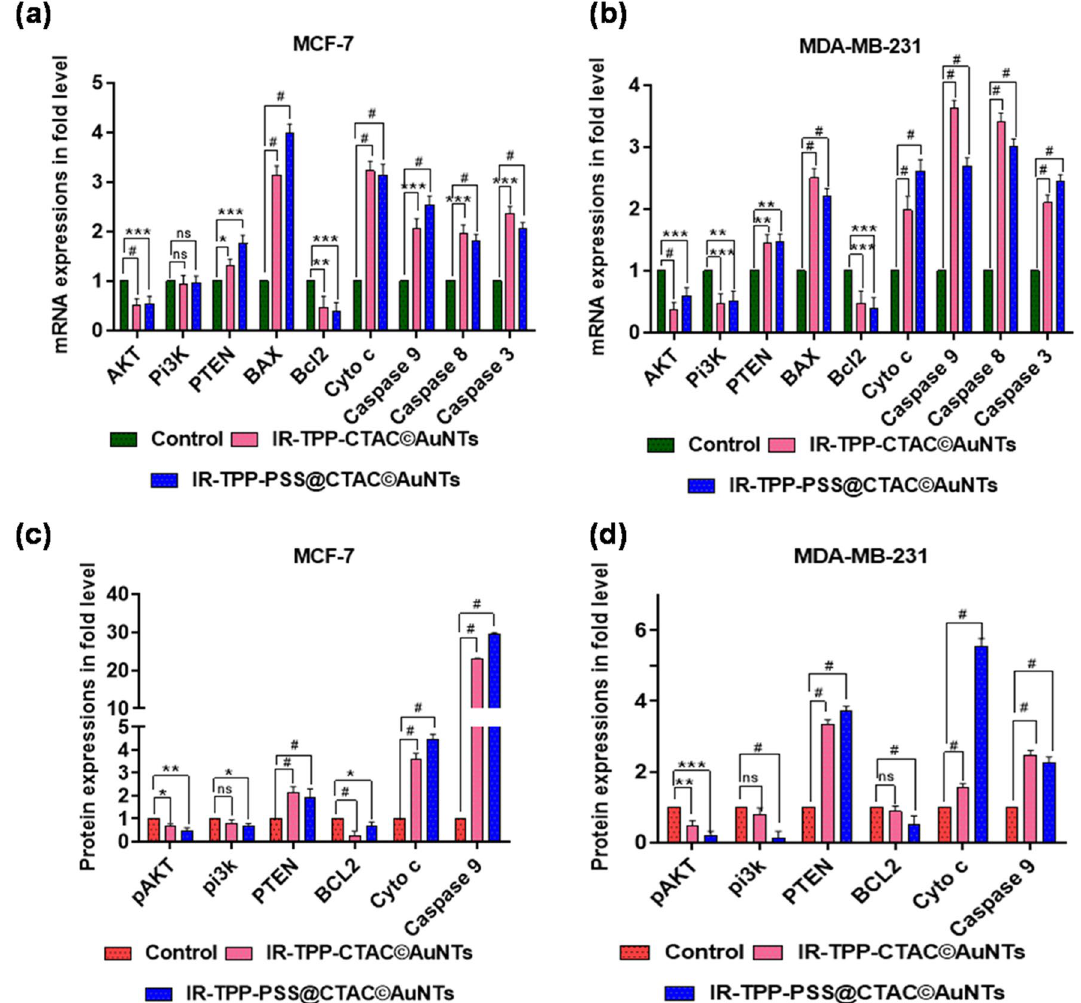
Figure 8. Representative graphs of semi-quantitative RT-PCR ( a , b ) and western blot analysis ( c , d ) showing the effects of gold nanoconjugates in the presence of 5-ALA mediated PDT on breast cancer cell in fold changes. All quantified values are represented as mean ± SD (n = 3). Statistical significance was performed by one-way ANOVA followed by Dunnett’s multiple test. Values are statistically significant at # p < 0.0001, *** p < 0.001, ** p < 0.01, * p < 0.05, and